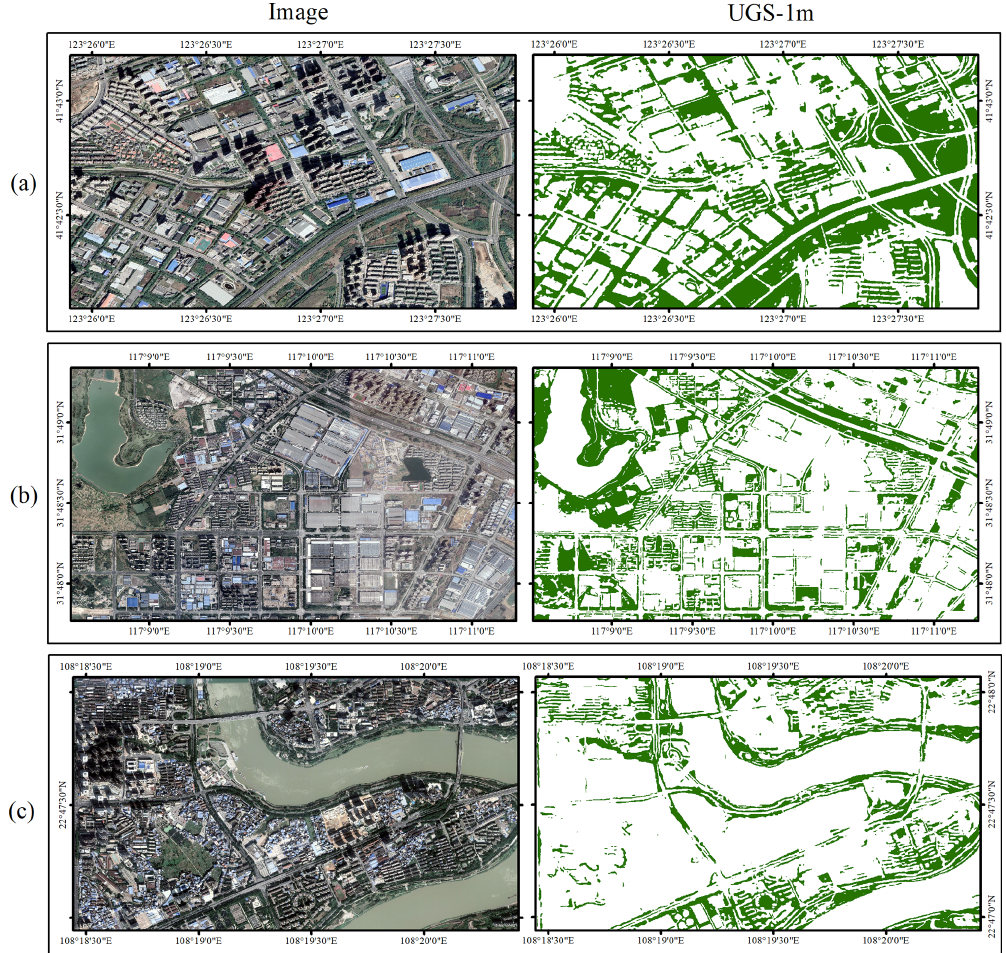
Figure 11. Detailed UGS results in UGS-1m from three capital cities. Images are from © Google Earth 2020. (a) Shenyang. (b) Hefei. (c)